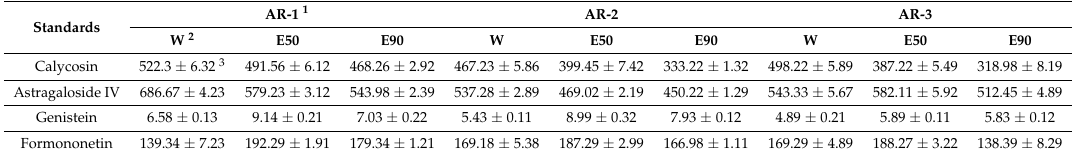
Three batches of AR, purchased from Shanxi province of China, were used in the present study. 2 W, water extracts of AR; E50, 50% ethanol extracts of AR; E90, 90% ethanol extracts of RA. 3 The values are expressed in mg/g of